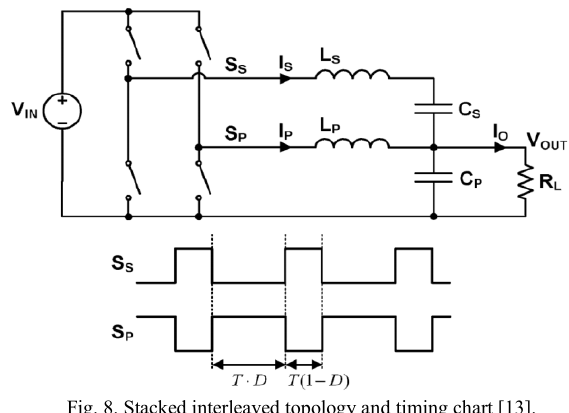
Fig. 8. Stacked interleaved topology and timing chart [13].